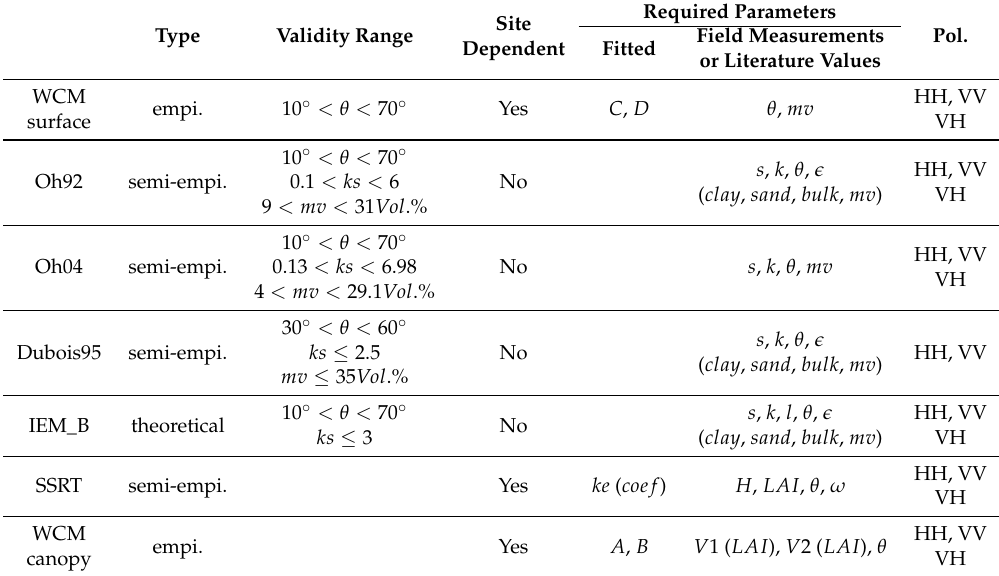
Table 4. Overview of differences of surface models Water Cloud Model (WCM surface), Oh models Oh92 and Oh04, Dubois95, and Integral Equation Model refined version of Baghdadi (IEM_B), as well as canopy models Single Scattering Radiative Transfer (SSRT) and WCM canopy, in terms of type, validity range, site dependency, required input parameters, and polarization. Separation of used input parameter of the analyzed Radiative Transfer (RT) models in fitted parameters and parameters where field measurements or literature values were used as input data.